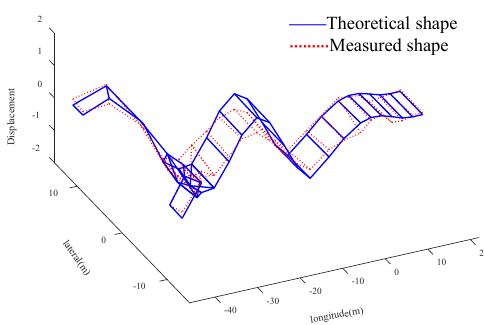
Figure 24. Comparison of the shape of 6th (cid:108) .